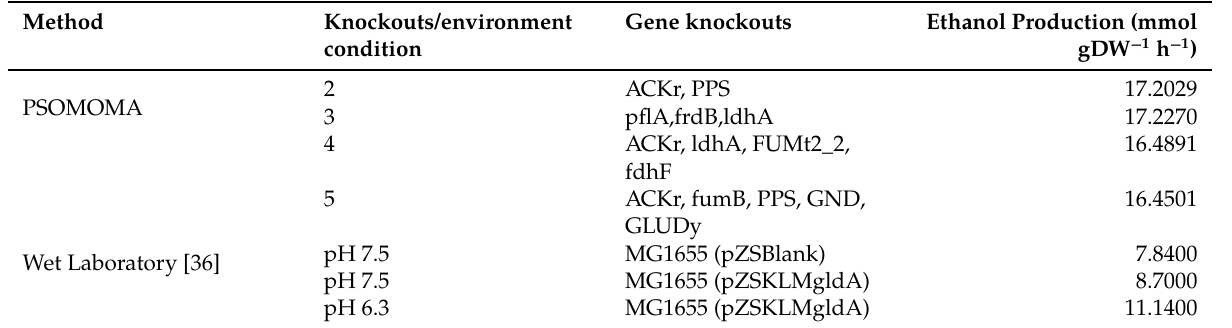
Table 4: Result comparison on ethanol production for PSOMOMA and Wet Laboratory Test.